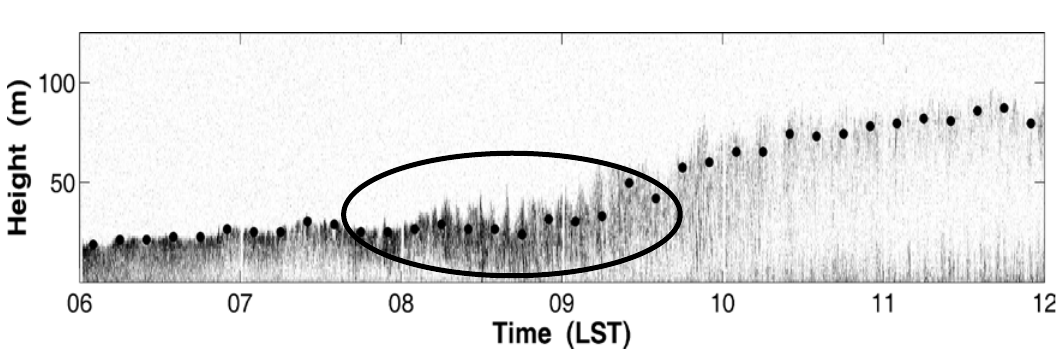
Figure 2 . Sodargram for 5 February 2012, the full dots represent the mixing height estimate. High ampli- tude waves are observed between 0800–0930